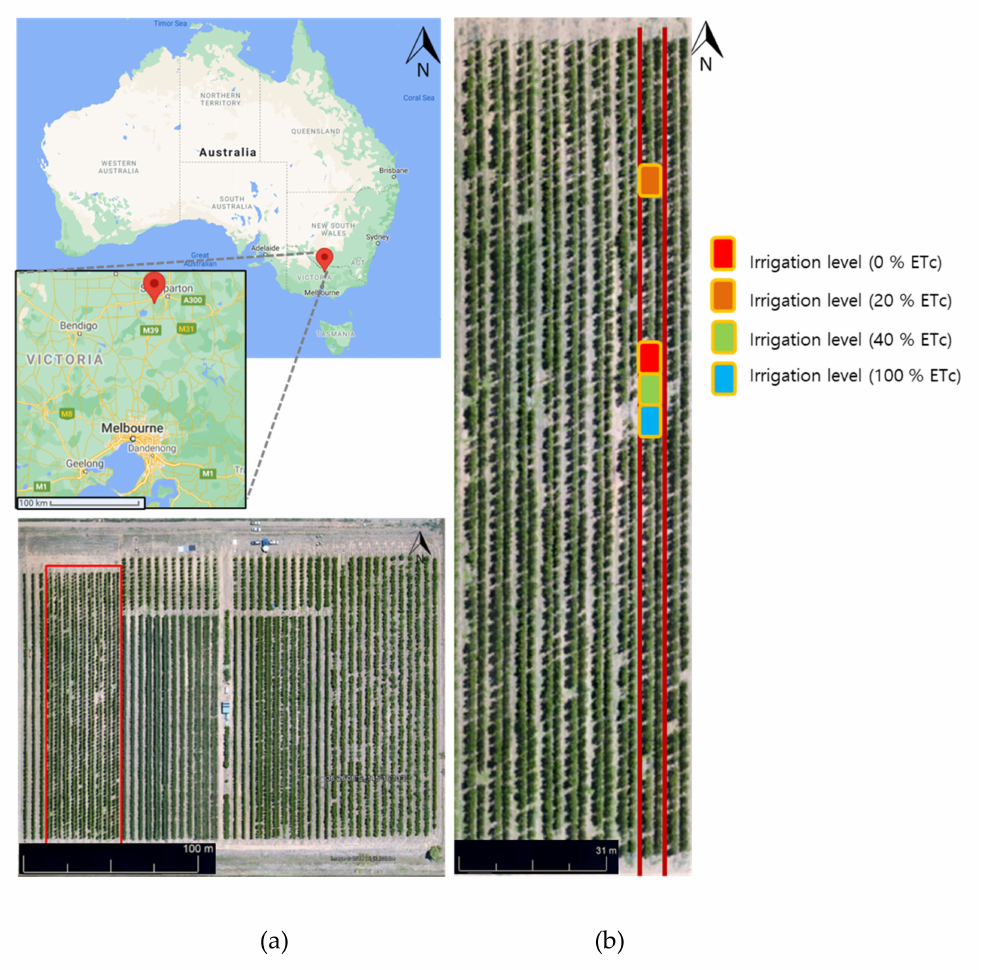
Figure 1. ( a ) Study site location, Stonefruit Experimental Orchard (Tatura, Victoria, Australia). ( b ) Different levels of water deficit plots are presented in red (0 % ETc), orange (20 % ETc), green (40 % ETc), and blue (100 % ETc)